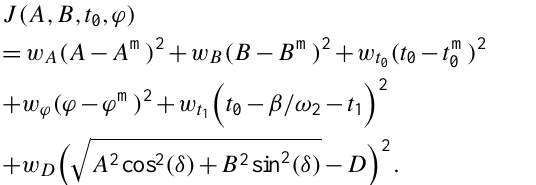
Fig. 8. Schematic representation of observational set up along with F IG . 8. Schematicrepresentationofobservationalsetupalongwith modelparameters some of the important model